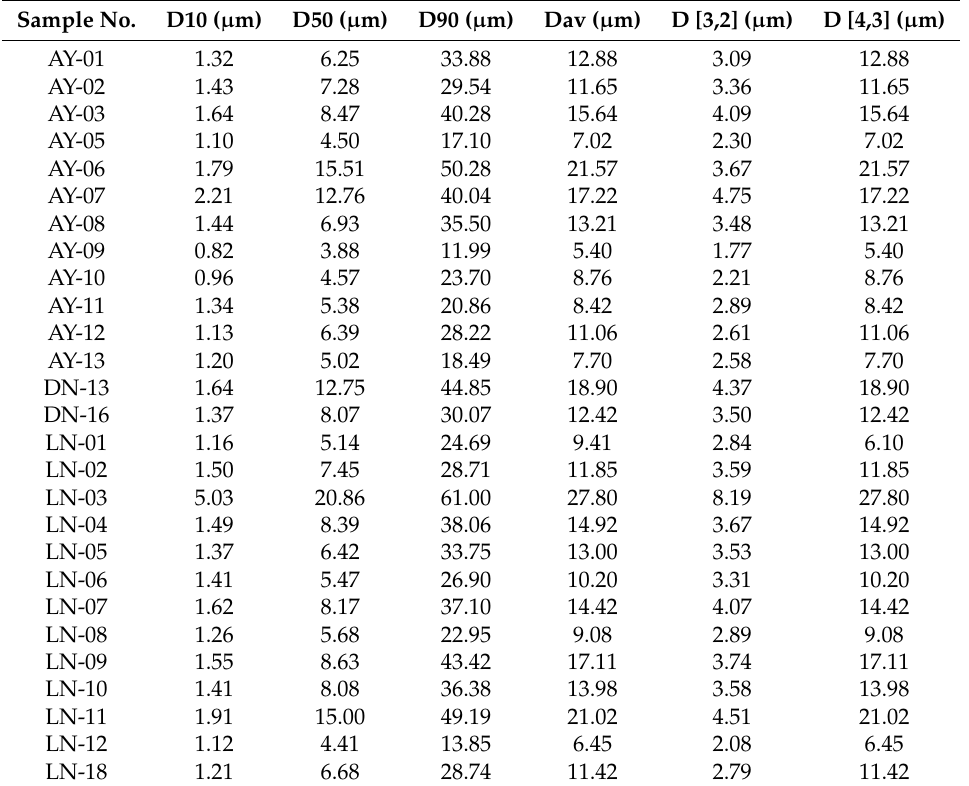
Table 5. Characteristic parameters of particle size distribution; regional weathering crust samples. Sample